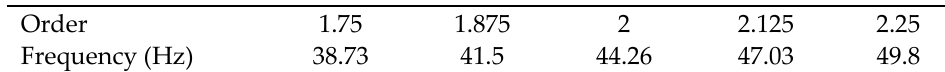
Figure 25. Analytical order identification of the experimental vibration measurements in the Qs48p8 machine.